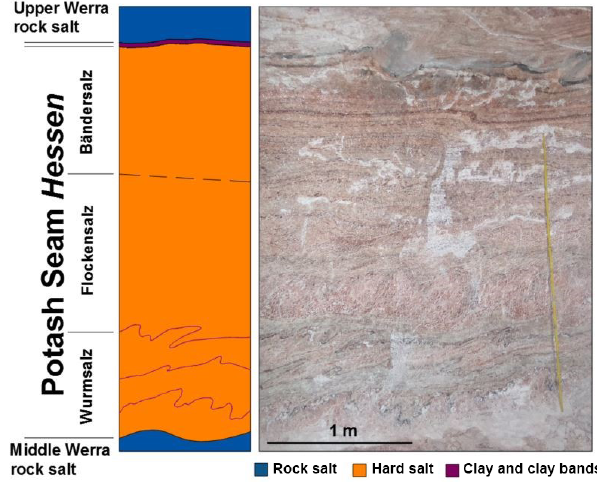
Figure 1. Typical appearance of sampling locations in Seam Hes-